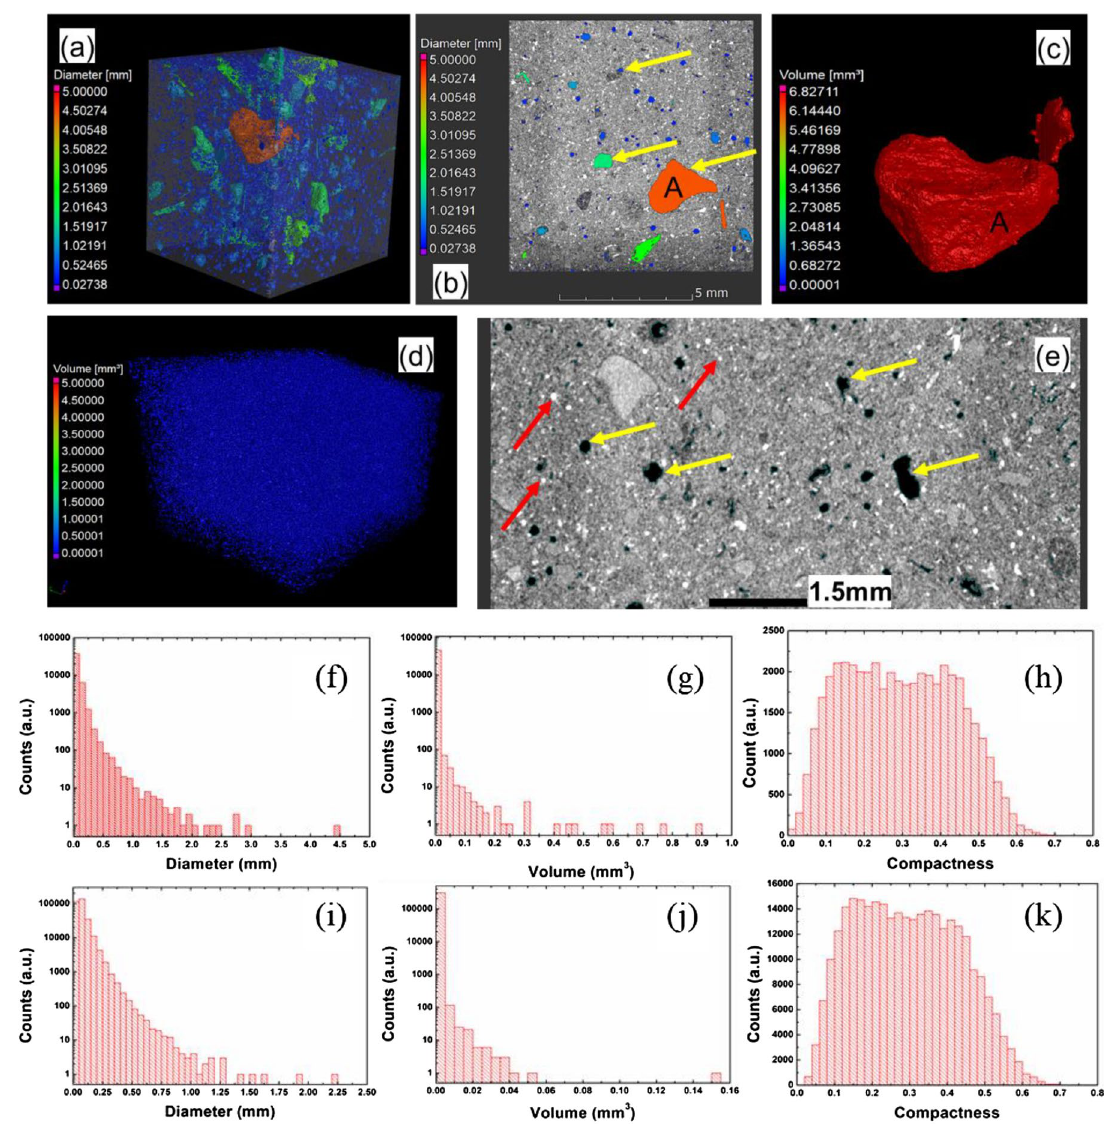
Figure 6. X-ray tomography on a sample from the burnt brick (B): ( a ) 3D rendering showing the pores; ( b , e ) 2D sections; ( c ) 3D rendering of the largest pore identified in the sample; ( d ) white particles mainly ascribed to quartz phase (see text); ( f – h ) diameter, volume and compactness distributions of the pores in the investigated sample; ( i – k ) diameter, volume and compactness distributions of the white particles in the investigated sample. Yellow arrows indicate the pores and red ones the white Fig. 6a–c,f–h. The largest pore attains a diameter of the surrounding sphere of 4.47 mm and a volume of 0.88 mm 3 . The maximum, relatively constant compactness is in the range of 0.15–0.45. Compactness shows deviation from the circumscribed sphere around the pore where a higher compactness means that the shape is closer to a sphere. It is calculated with the formula: = Volume (2) Compactness of the pore / Volume of circumscribed sphere The particles of intense white color (> 30 µm) indicate on their high radiological density. The theoretical densi- ties of the minerals identified by XRD in our samples are not much different (Supplementary material Table 4). Hence, it is impossible to distinguish them among the other phases by XRT. From the microscopy analysis (see “Microstructural aspects of the burnt brick from Romula”, Fig. 12), the largest, relatively well distributed are the particles of silicon oxide. Therefore, we shall consider that most of the as-revealed large white particles in XRT are of quartz (SiO 2 ), while smaller ones may also belong to other phases. The largest white particle from the investigated burnt brick sample has a diameter of 2.22 mm, a volume of 0.53 mm 3 , and the compactness is relatively constant or it has a decreasing trend between 0.15 and 0.45.